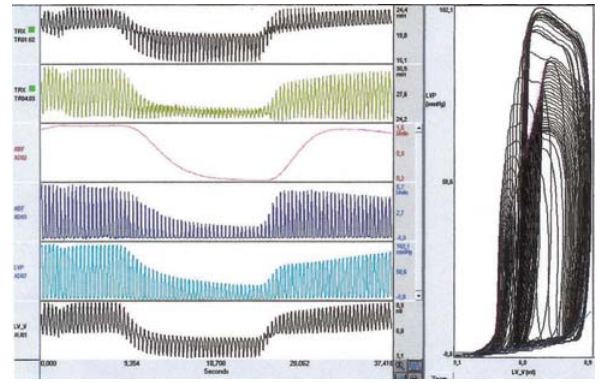
Fig. 4 - Visão de tela típica do programa utilizado. À esquerda, o registro da monitorização dos cristais e curvas obtidas. À direita, exemplo de curva de volume-pressão típica com variação de pré- carga. Da variação destas curvas foram obtidos os índices de contratilidade pesquisados.